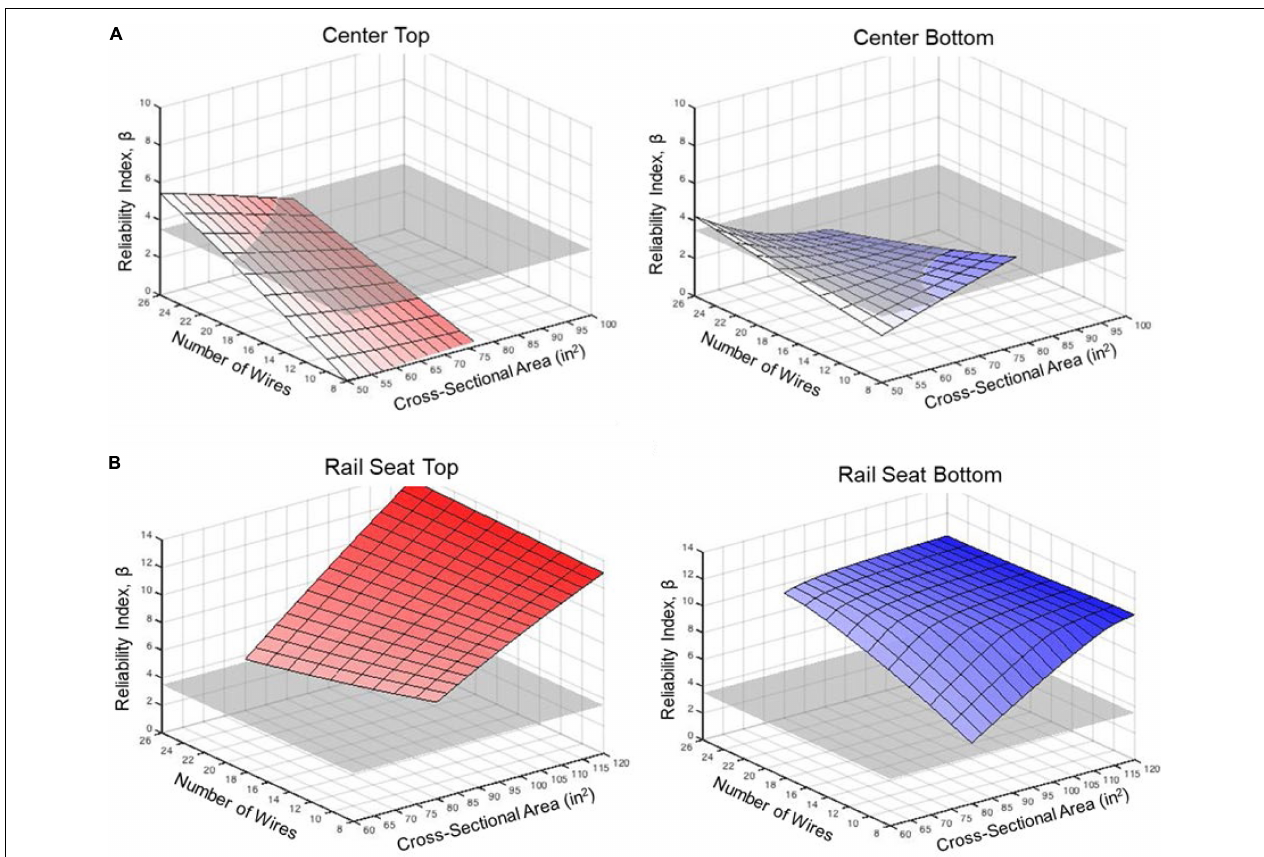
of holding gauge and supporting the rail. Center cracking has been shown to be less critical by recent research by Bastos et al. (2017), but is a location that is often found to be out of compliance with the FRA Track Safety Standards (CFR 213)